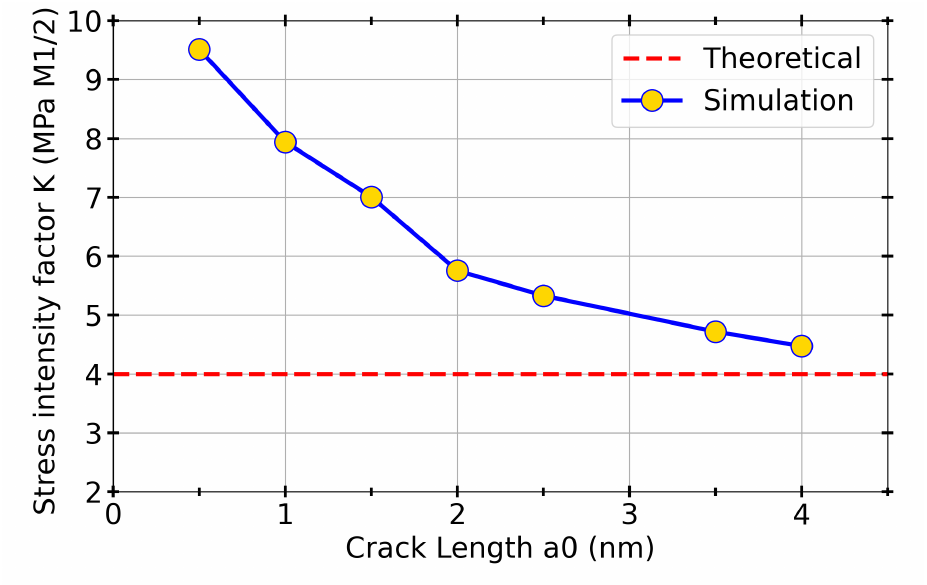
Figure 8. Crack length a 0 effects on fracture toughness. The tensile simulations are per- formed under the parameters of temperature T = 300 K; pressure P = 0.0001 GPa; strain rate = 1 × 10 9 s − 1